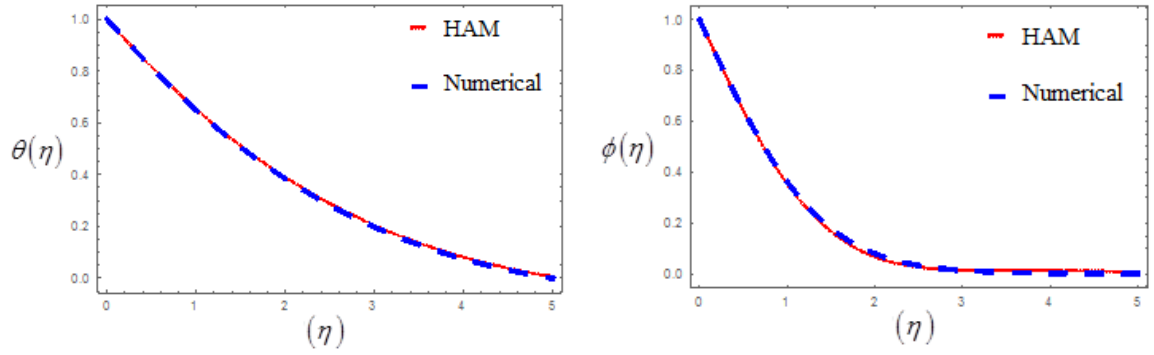
Figure 2. Assessment of RK4 and HAM for θ ( η ) and φ ( η ) .